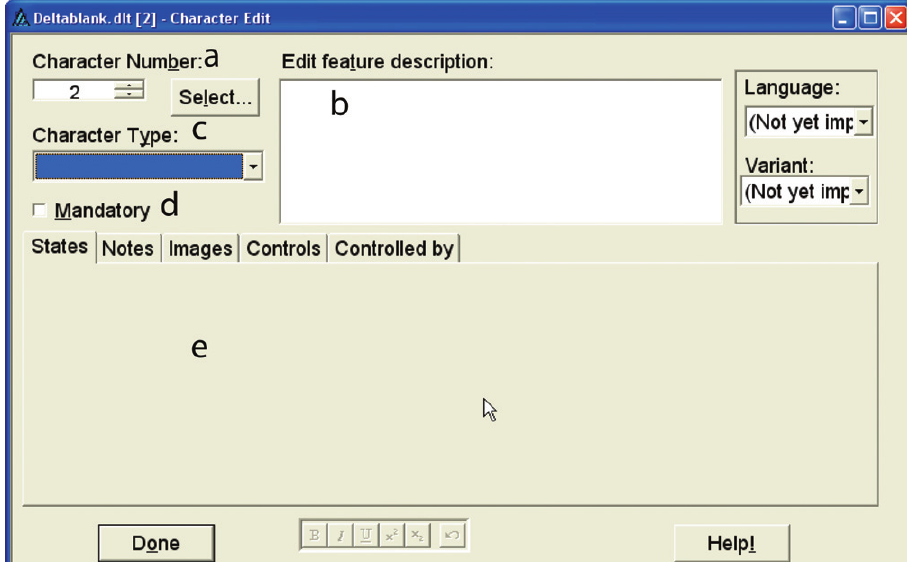
Figure 4a–e. Character editor, explanations in the